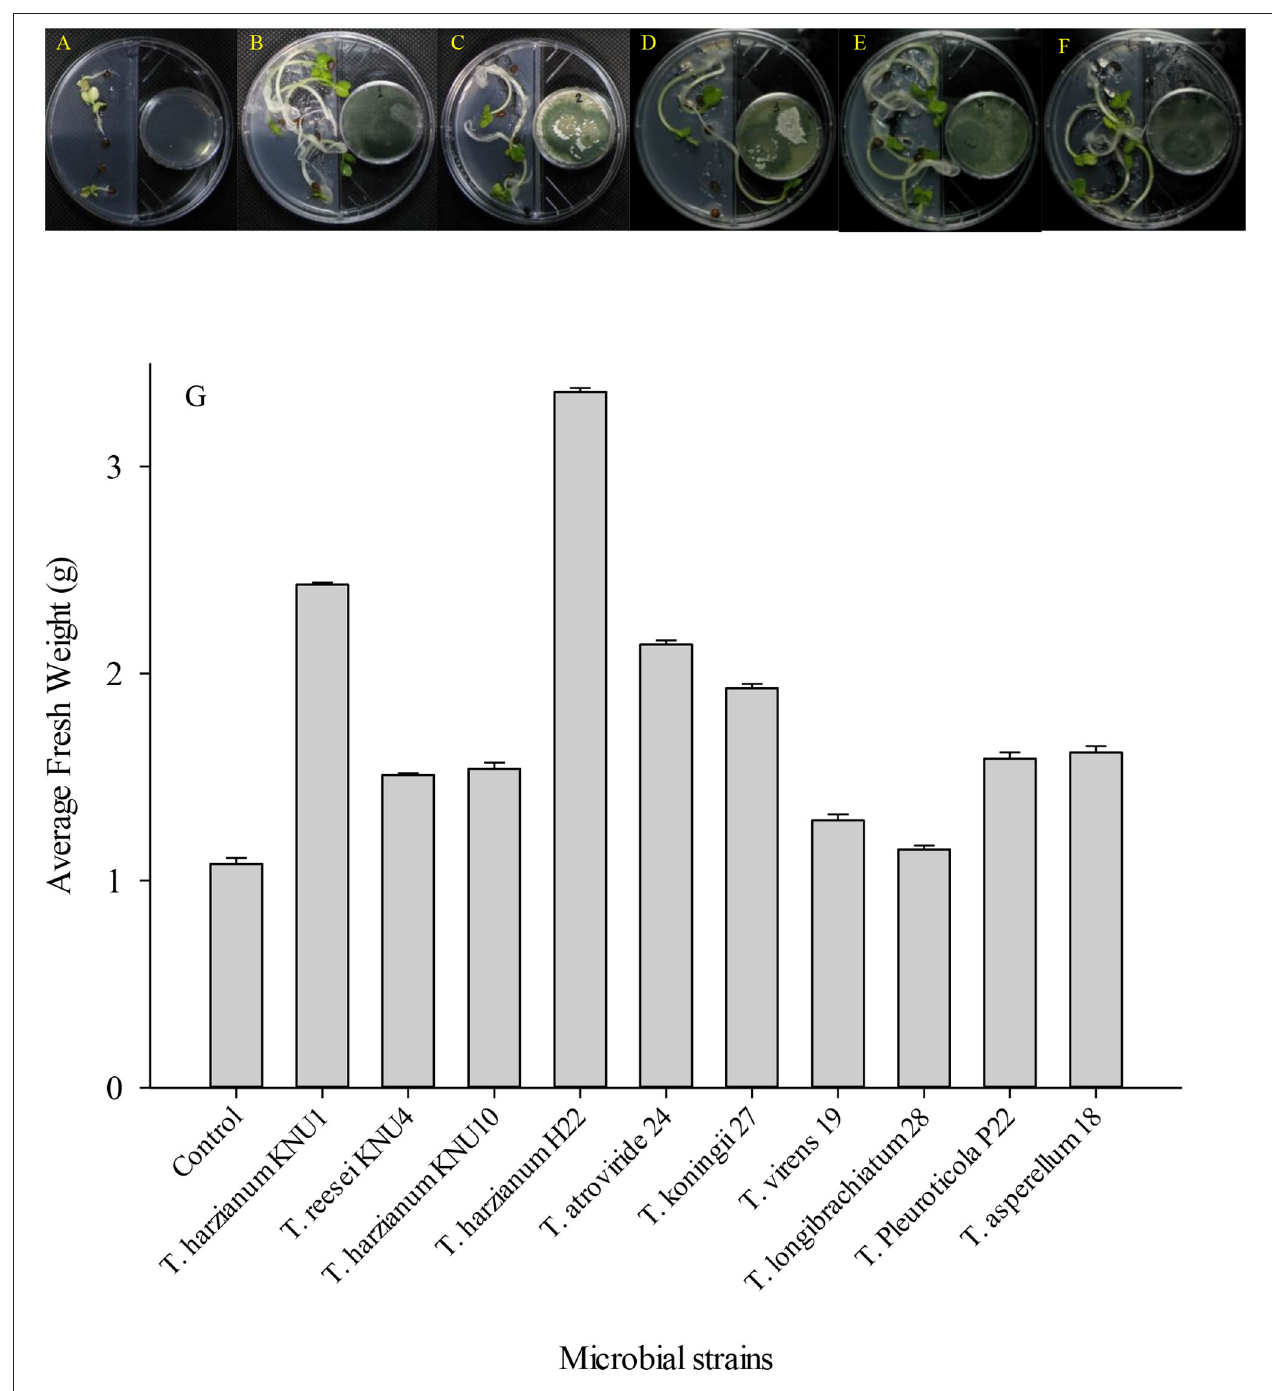
FIGURE 3 | The development of Raphanus sativus L. seeds in Murashige and Skoog solid medium in response to plant growth-promoting Trichoderma -volatiles exposure of (A) Un-inoculated control; (B) T. harzianum KNU1; (C) T. reesei ; (D) T. harzianum KNU10; (E) T. harzianum H22; and (F) T. atroviride . The I-plates were sealed with Parafilm tape and incubated randomly in the growth chamber which was adapted to 25 ◦ C and 12:12-h (LD) cycle. (G) Fresh weight average induced in radish seeds by the VOCs released by different Trichoderma strains.